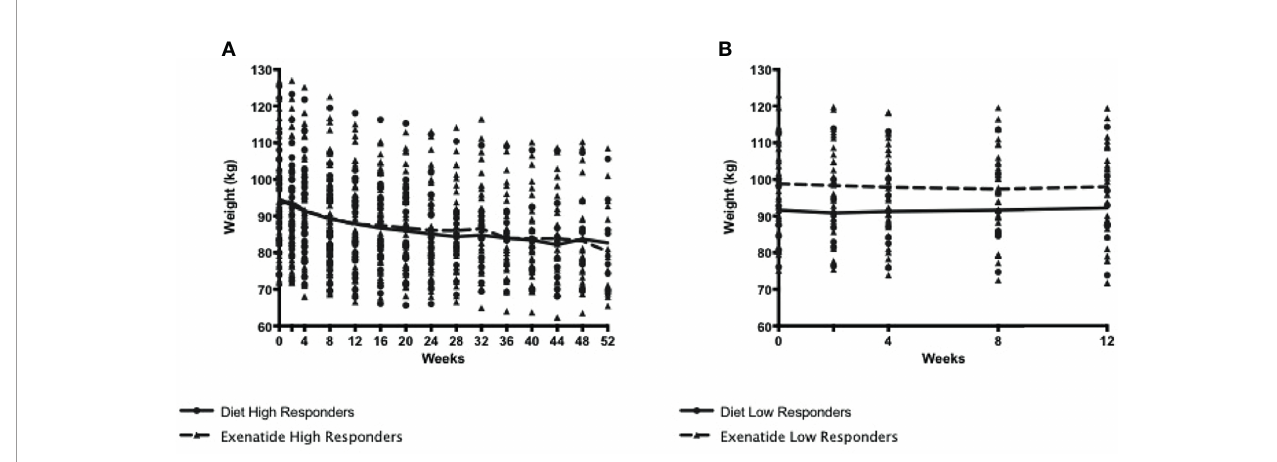
FIGURE 2 | (A) . Weight loss among exenatide and diet high responders over 52 weeks (B) Weight loss among exenatide and diet low responders over 12 weeks. By protocol design, low responders ended study participation at 12